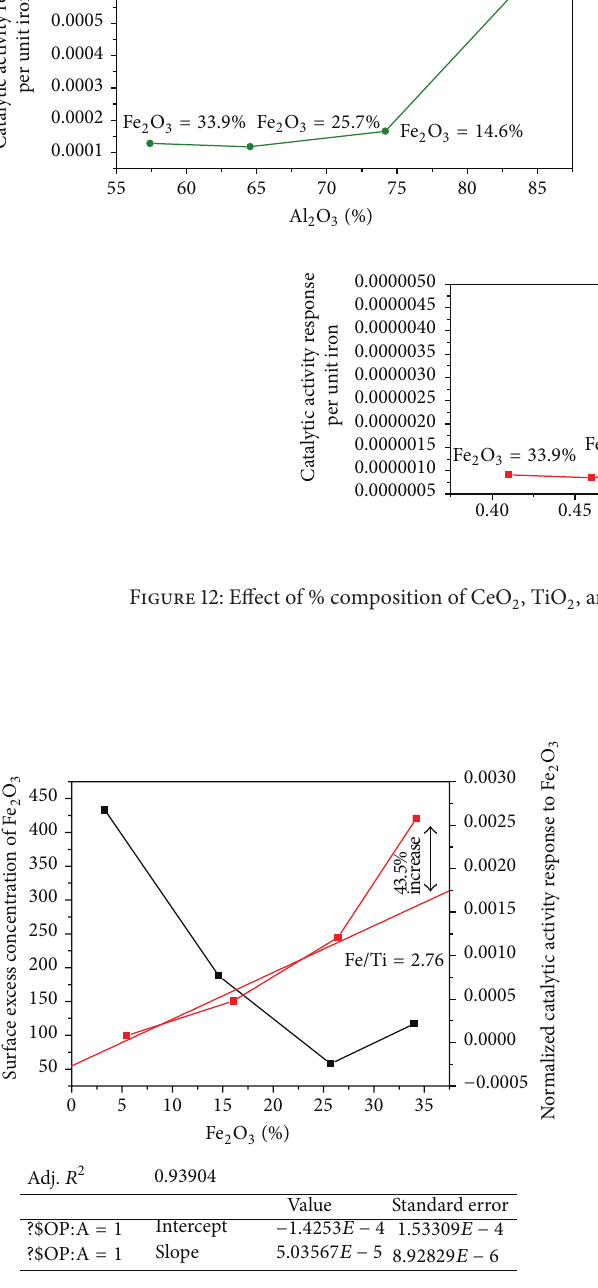
Figure 13: The surface excess concentration of iron oxide has been correlated with both % Fe 2 O 3 and catalytic activity response normalized with respect to iron oxide.